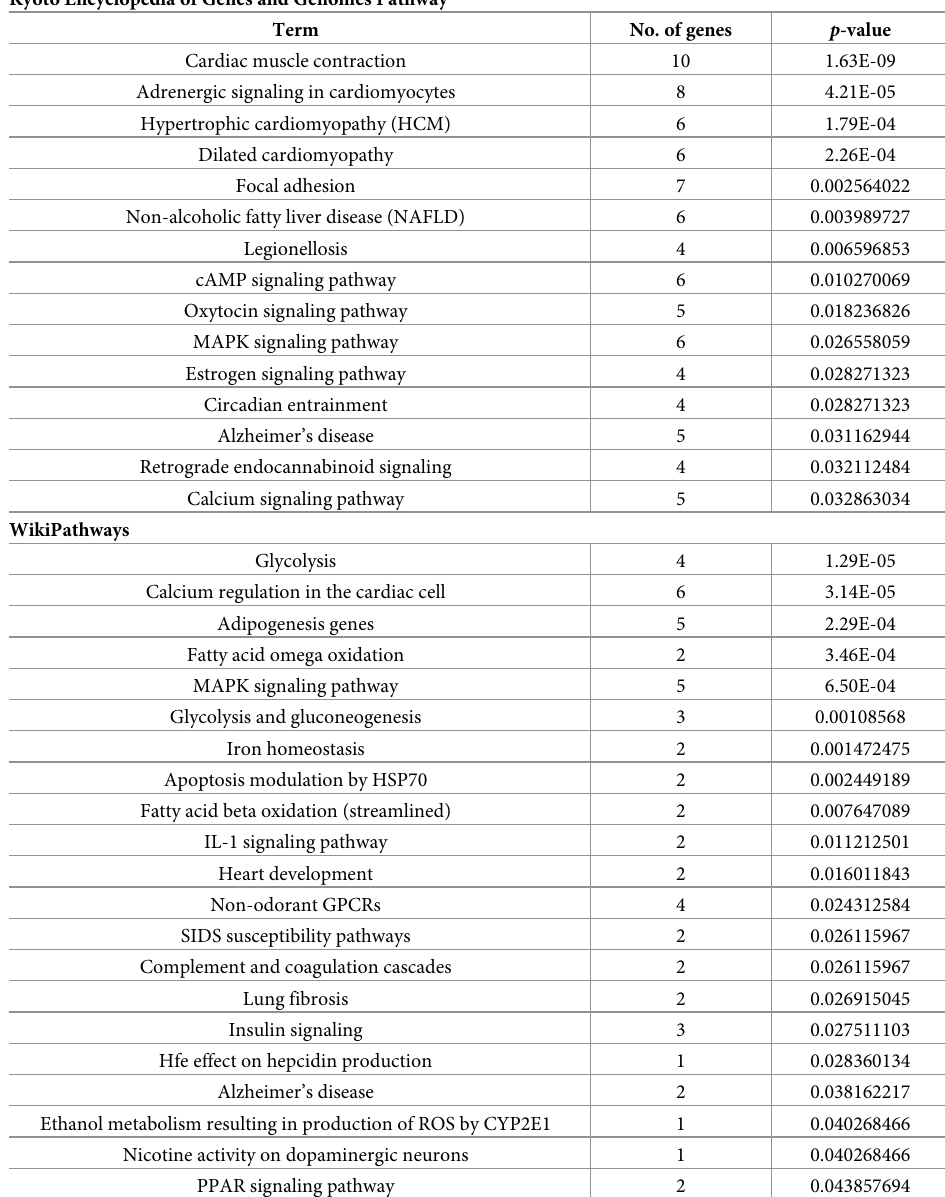
Table 2. Results of pathway analyses using Kyoto Encyclopedia of Genes and Genomes pathway or WikiPathways. Kyoto Encyclopedia of Genes and Genomes